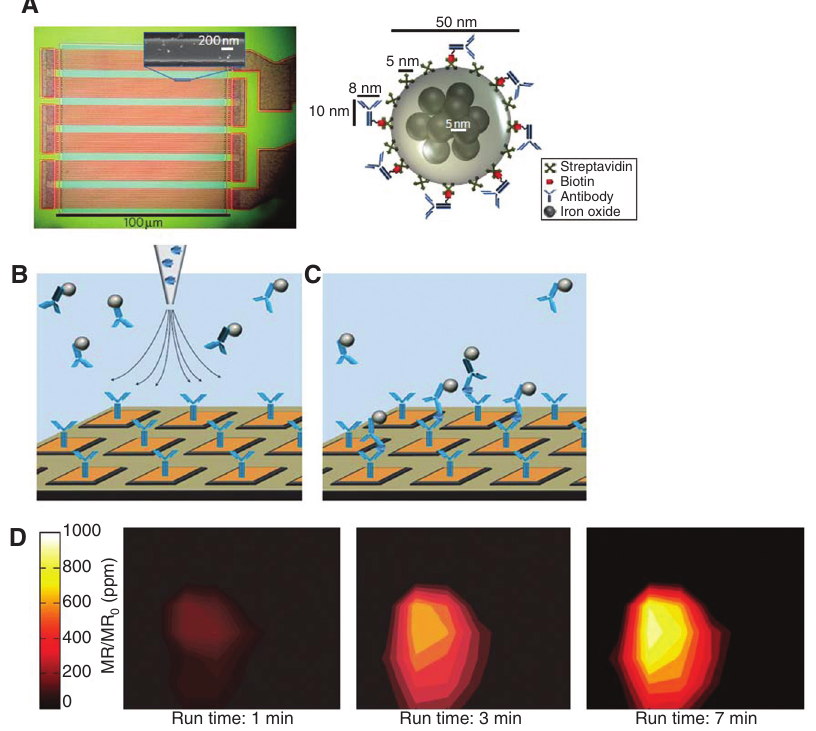
Figure 7 GMR nanosensor system for kinetic analysis. (A) optical micrograph showing the GMR sensor architecture comprising 72 stripes connected in parallel and in series. Inset: SEM image of one stripe of the GMR sensor with several bound magnetic nanoparticle tags. (C) Schematic representation of a magnetically labeled antibody, drawn to scale. The magnetic tag comprises a dozen iron-oxide cores embedded in a dextran polymer and then functionalized with antibody or receptor. (B) Schematic depicting the GMR sensor array functionalized with monoclonal anticarcinoembryonic antigen (CEA) capture antibody (not to scale). The solution above the sensor array is composed of magnetically labeled anti-CEA detection antibodies. The schematic includes a pipette tip containing a solution of CEA protein before injection. (C) Once the CEA antigen is introduced into the solution above the sensor array, radial transport of CEA antigen from near the centre of the array is monitored in real time. Magnetically labeled detection antibodies capture CEA protein and bind to anti-CEA antibodies on the GMR sensor surface to form detectable sandwich structures. (D) Visualization of CEA protein surface concentration at different times using a high-density GMR sensor array. The units of the y-axis are presented in changes in MR normalized to the initial MR